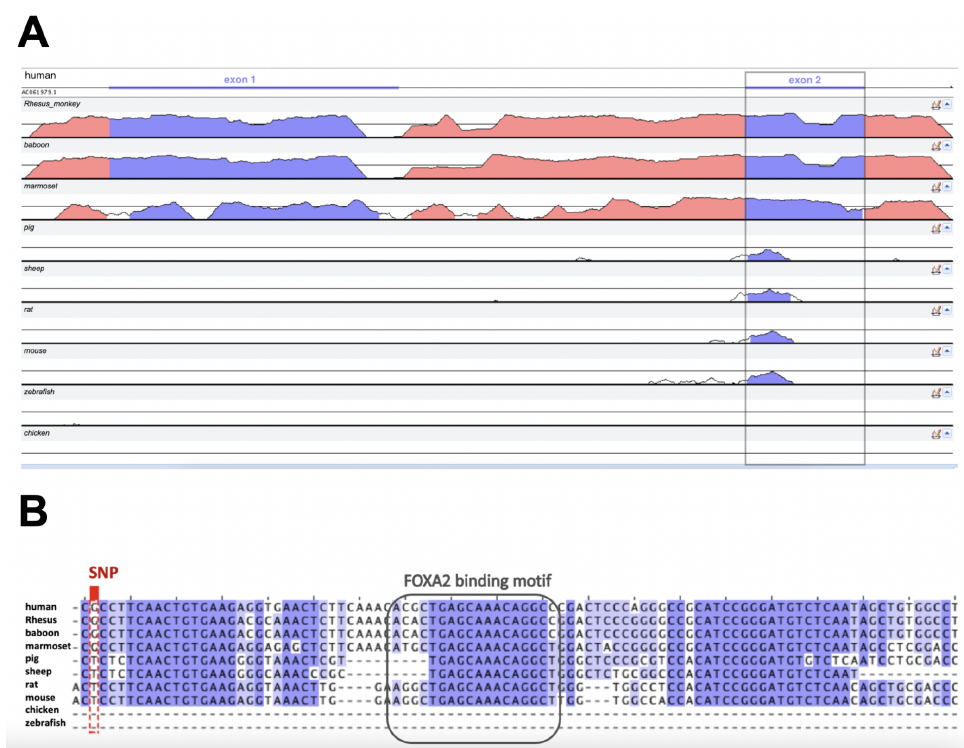
Figure 3. Conservation of the MUC5B-MUC5AC intergenic region across 10 species. ( A ) The genomic sequences were aligned using AVID in mVISTA: global pair-wise alignment between ∼ 2000 nt spanning the human AC061979.1 transcript and the whole intergenic region of the other species ( ∼ 20,000 nt; Table S2). Coloured peaks (purple: AC061979.1 exons; pink: intergenic regions) indicate at least 50 bp with 70% similarity. The grey rectangle indicates the conserved exon across mammals. ( B ) Multiple Sequence Alignment by ClustalOmega in Jalview shows that 100 nucleotides downstream of rs35705950 (red rectangle) there are (i) 15–25 bp conserved across mammals (purple shades by nucleotide similarity percentage), (ii) a FOXA2 binding site (grey rectangle), and (iii) a third